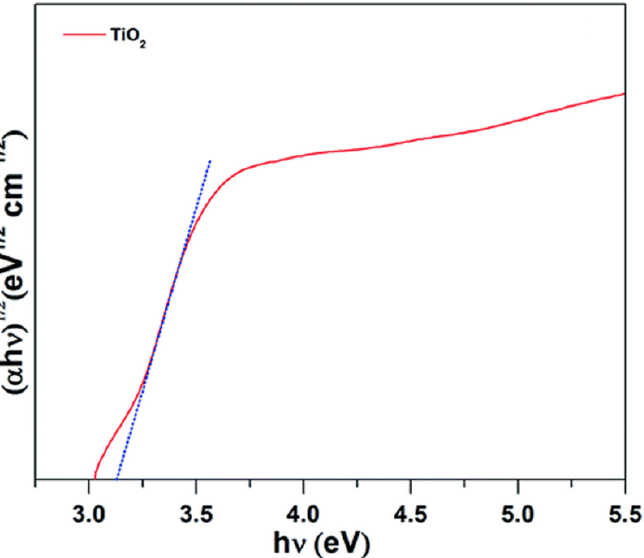
Figure 3. The Tauc plot of TiO 2 . Reprinted with permission from Ref. [85]. Copyright 2015, Royal Society of Chemistry.